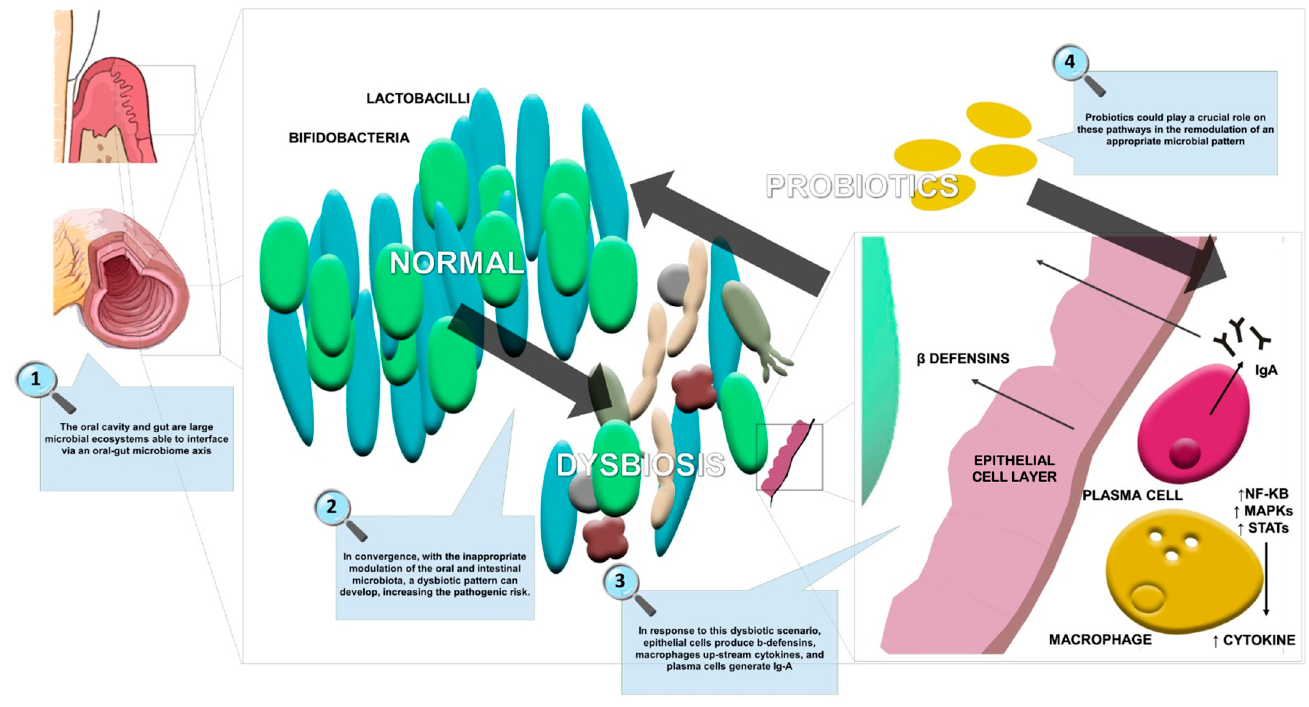
Figure 2. The effects of probiotics in oral and gut dysbiosis.